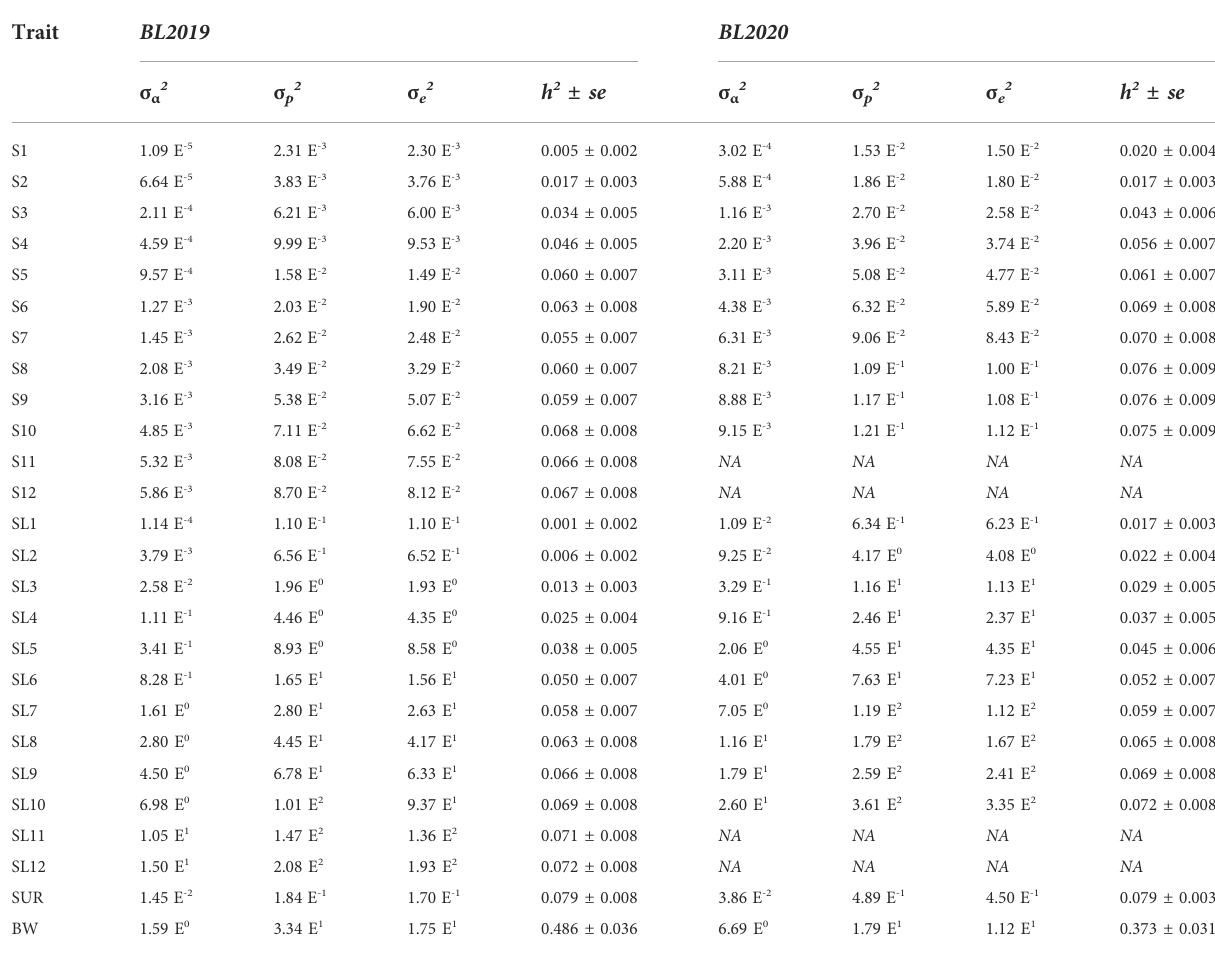
TABLE 3 Estimates of variance components and heritabilities ( h 2 ± se ) for the genetic analyse of survival data and body weight. Trait BL2019